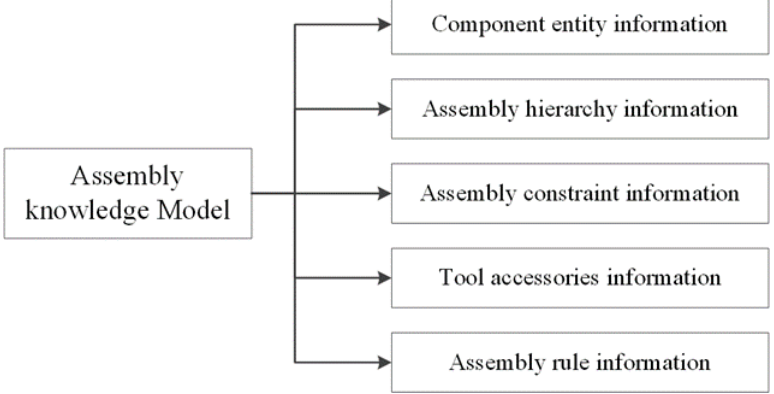
Figure 7. Classification of assembly knowledge model information.